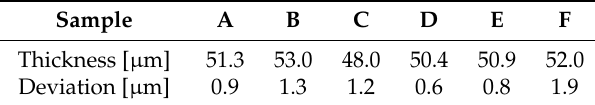
Table 3. Juxtaposition of oxide layer thicknesses.